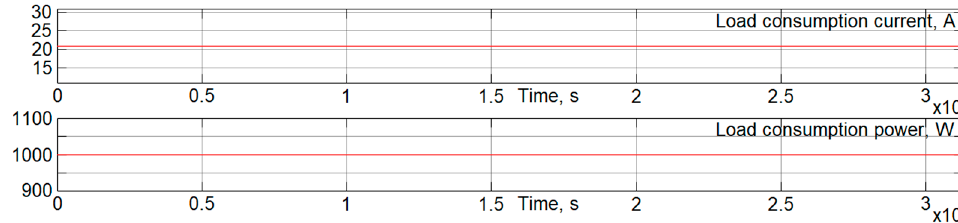
Figure 16. The parameters (current and power) of consumption in each location are equal.